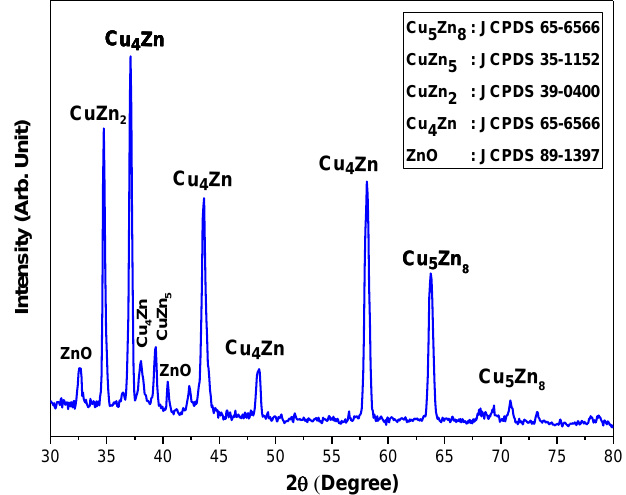
Figure 1. XRD pattern of Zn-Cu alloy growth on AZ63 substrate.